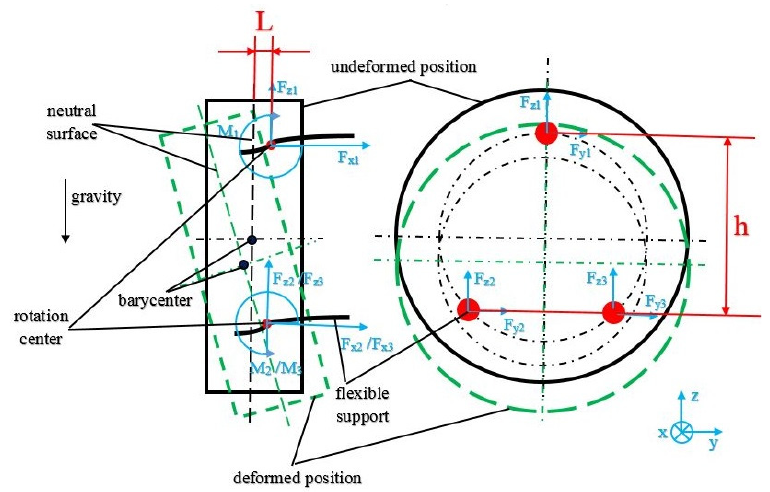
Figure 8. Stress condition of the flexible structure when the mirror is placed vertically.